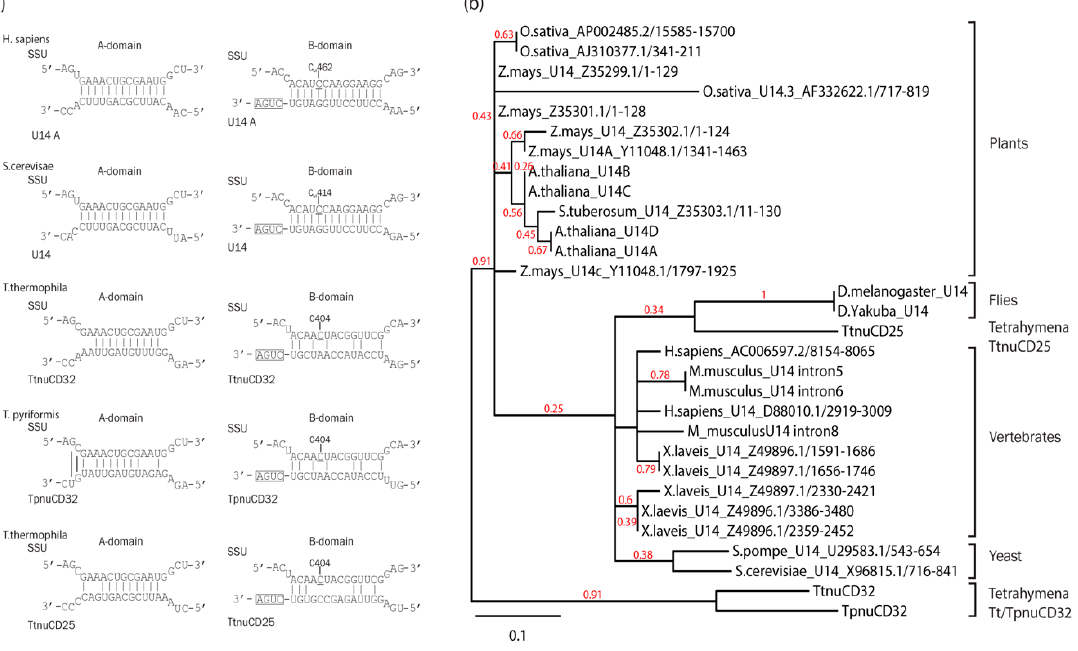
Figure 5. Comparison of TtnuCD32, TpnuCD32, and TtnuCD25 to snoRNA U14 from various species: ( a ) Interactions between the A and B box sequences of U14 snoRNA from yeast ( S. cerevisae ) and human ( H. sapiens ) as well as the corresponding regions in TtnuCD32 and TpnuCD25 from T. thermophila and T. pyriformis and their SSU rRNA targets; ( b ) A cluster analysis of U14 sequences from different eukaryotes as marked for each branch. Broader phylogenetic groups are noted at the side of selected clusters. Branch support from a bootstrap analysis with 500 replicates are shown at branches if above 0.25.